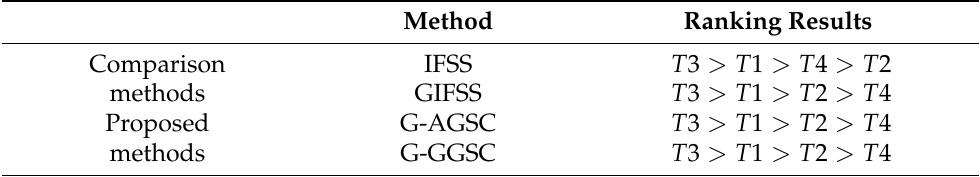
Figure 6. The score values of the targets under different methods in the tradtional index system. The ranking results of the proposed methods and comparison methods are shown in Table 6. Table 6. Ranking results of the targets under different methods in the tradtional index